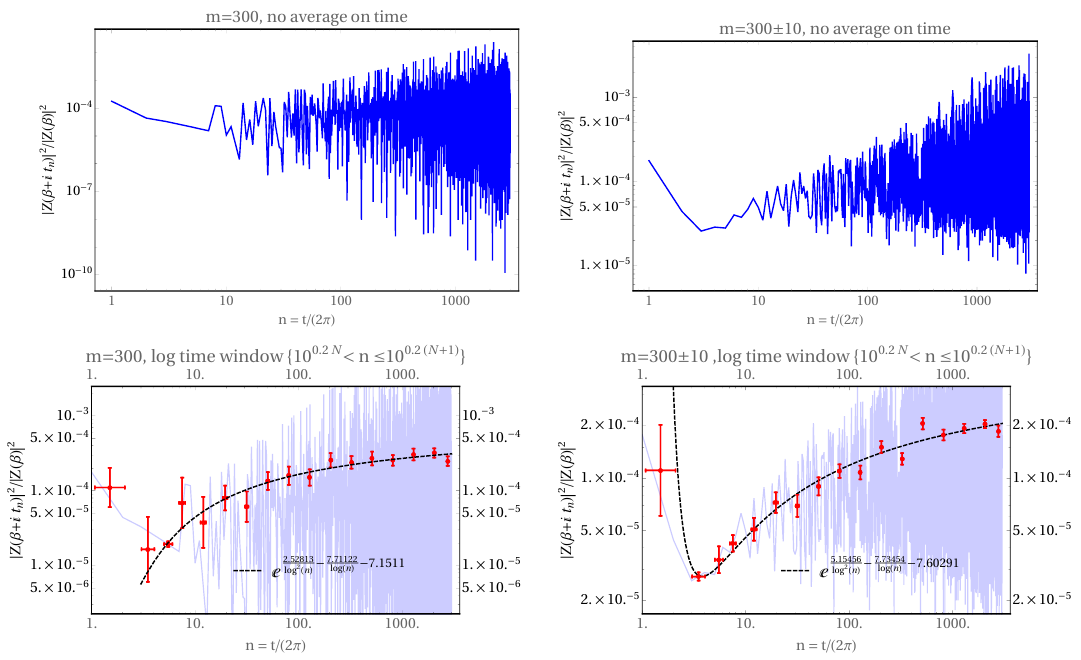
m = 300, log time window { 10 0.2 N < n ≤ 10 0.2 ( N + 1 ) }